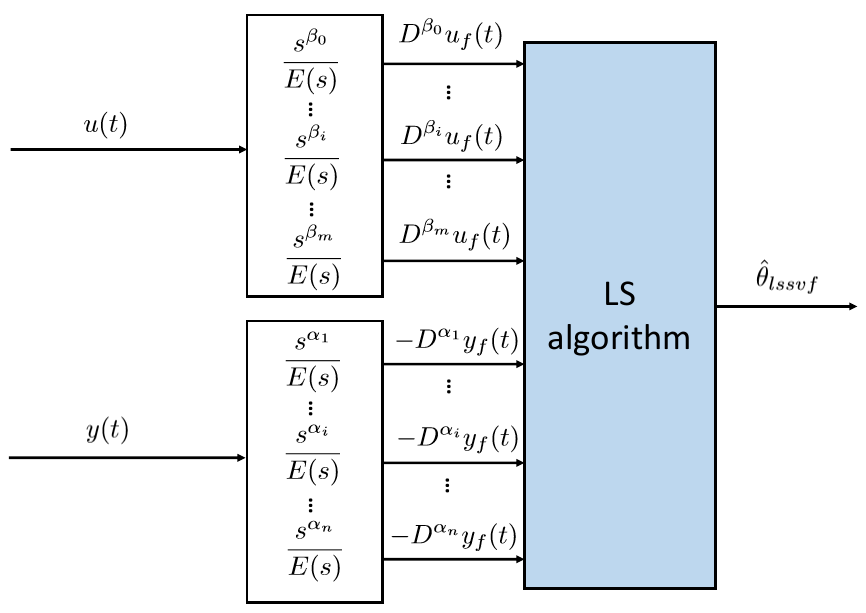
Figure 5. The least squares-based state-variable filter (LSSVF)